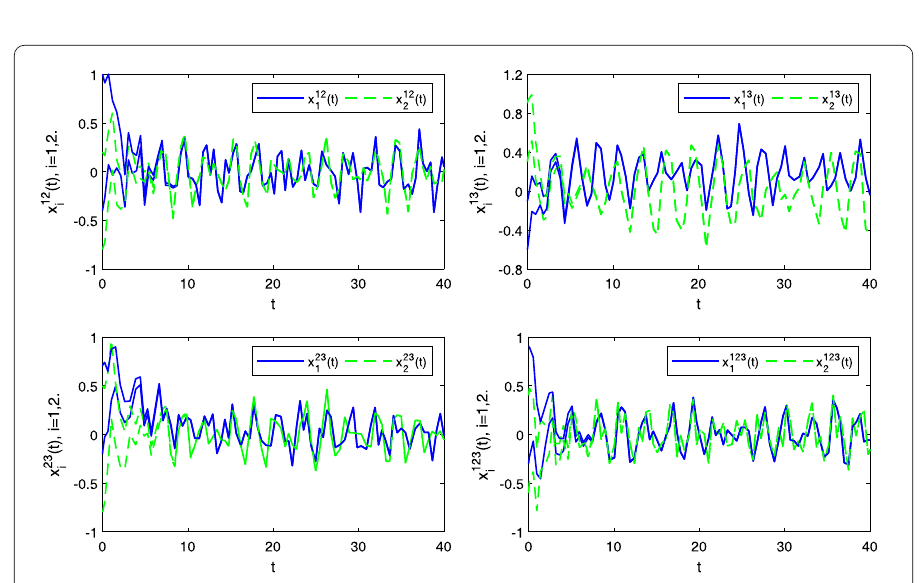
Figure 2 T = R . Transient states of x 12 ( t ), x 13 ( t ), x 23 ( t ), and x 123 ( t